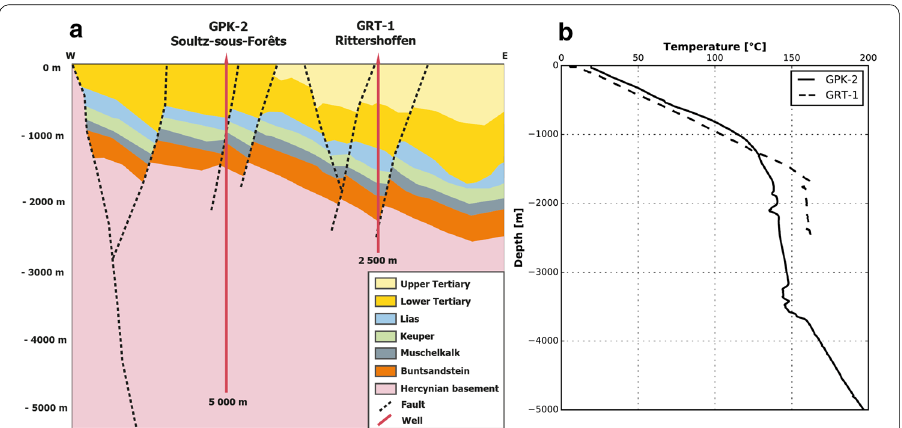
Fig. 2 a East–West simplified vertical section of the Rhine Graben crossing the Soultz-sous-Forêts GPK–2 and the Rittershoffen GRT-1 wells (from Edel et al. 2018); b temperature logs, at equilibrated thermal conditions, for the Soultz-sous-Forêts GPK-2 well (from Genter et al. 2010) and for the Rittershoffen GRT-1 well (from Baujard et al. 2017) (vertical scale is in